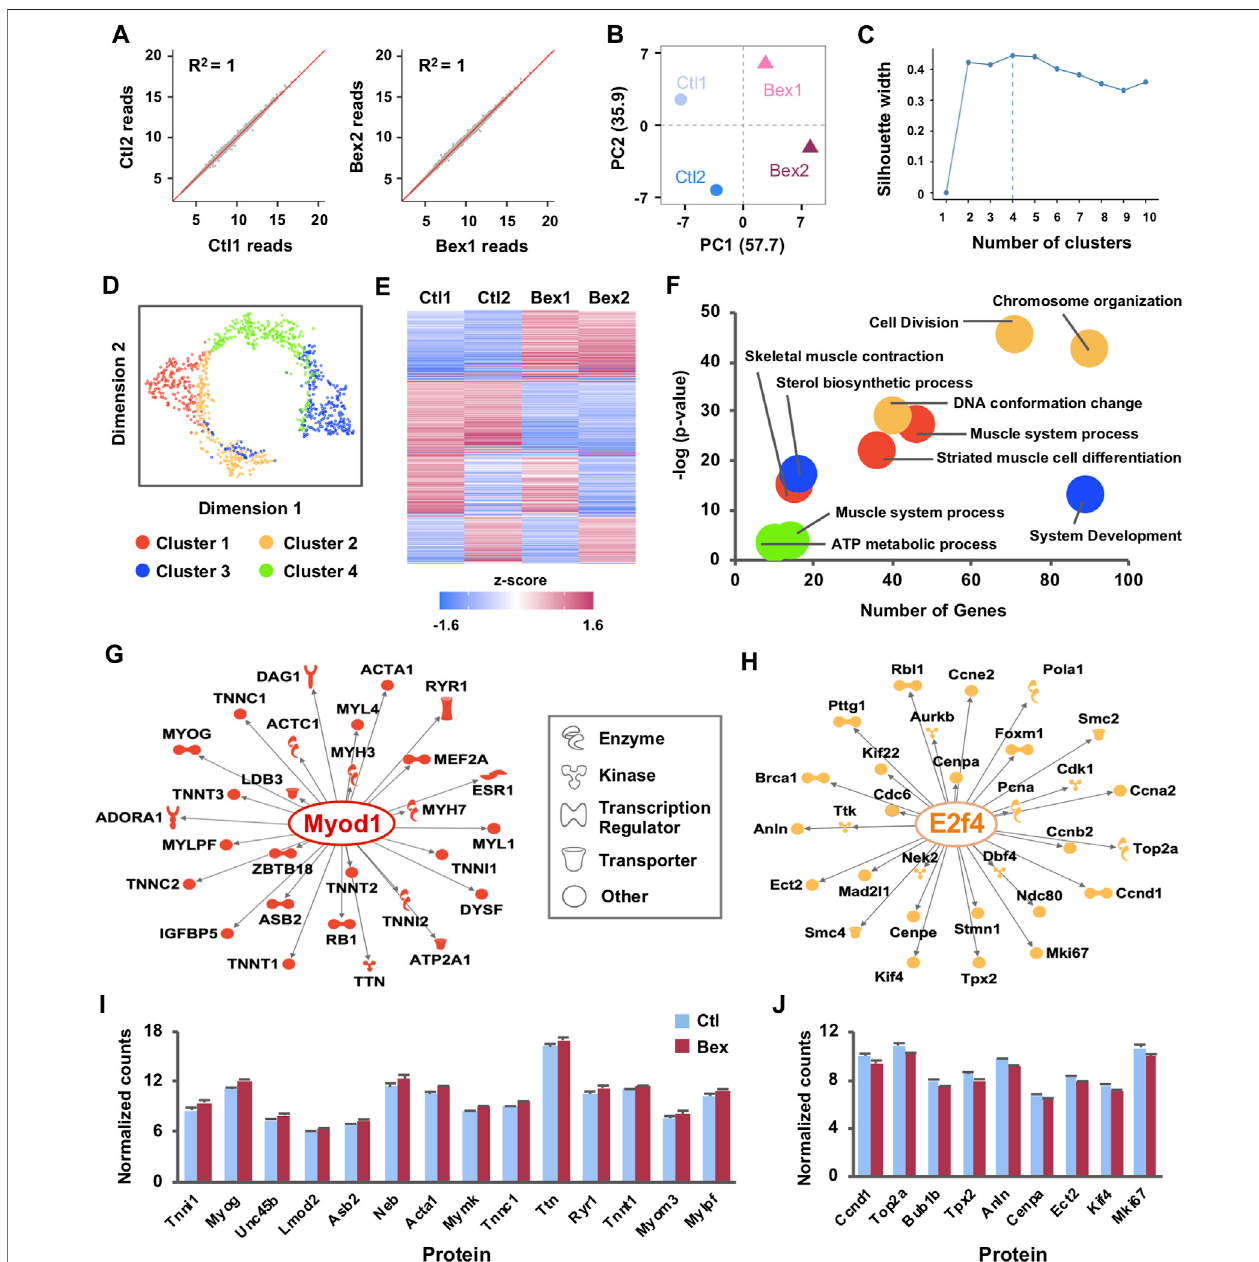
FIGURE 1 | Gene expression clusters reveal distinct gene regulatory networks activated by RXR signaling in myoblast differentiation. (A) C2C12 myoblasts were differentiated for 24 hin theabsenceorpresence ofbexarotene and subjectedtoRNA-seq analysisintworeplicates (Ctl1and Ctl2; Bex1 and Bex2). Correlationscatter plots of normalized read counts are shown with linear regression and coef fi cients of determination (R 2 ). (B) PCA plot of normalized read counts shows the amount of variance across replicates and conditions. (C) The Silhouette method was applied to the top 1,000 most variable genes to determine the optimal number of clusters. The average silhouette width was maximized at k (cid:1) 4 clusters. (D) Dimension reduction algorithm was applied to create a t-SNE map which illustrates the relationshipsbetweenclustersofco-expressedgenes. (E) Heatmapofk-meansclusteringonexpressionpro fi lesnormalizedbymeancenterforthe1,000mostvariably expressed genes across RNA-seq replicates. (F) Gene ontology terms enriched in each cluster are displayed. (G) The Regulator Effects tool of the IPA package was employedtoidentifyup-streamregulatorsofthenetworks ofdifferentiallyexpressed genesrelatedtomuscledevelopmentfromClusterIand (H) cellcyclerelated genes from Cluster II. The molecular networks display direct gene interactions only (p-value < 0.01) and the shapes of the nodes re fl ect the functional class of each gene product. (I) Expression patterns of a subset of differentially expressed genes from Cluster I and (J) Cluster II, presented as normalized RNA-seq read counts.